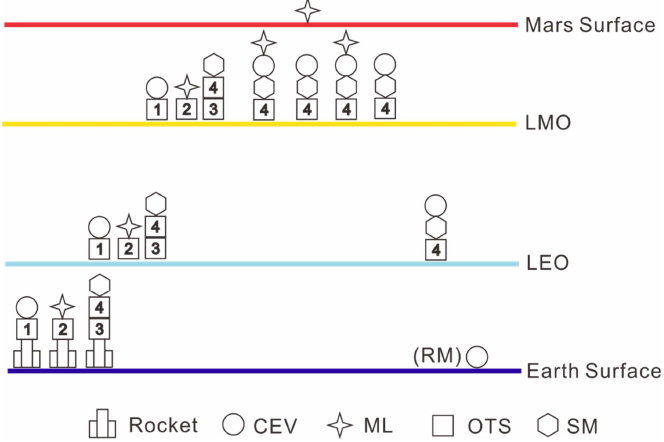
Figure 12. Schematic of